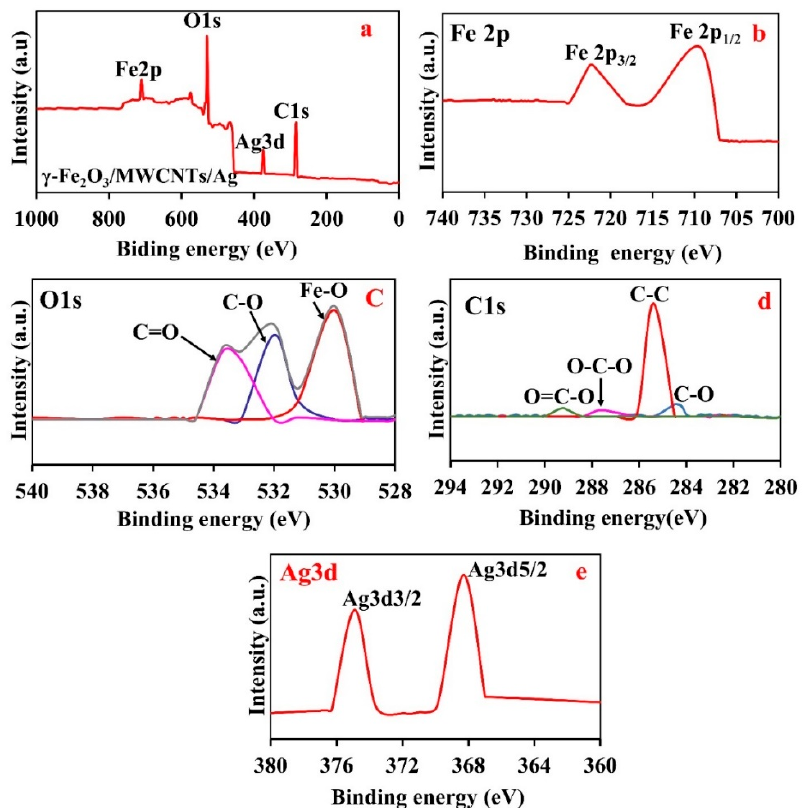
Figure 5. XPS analysis of the γ -Fe 2 O 3 /MWCNTs/Ag NC particles: ( a ) general XPS, ( b ) Fe2p, ( c ) O1s, ( d ) C1s, and ( e ) Ag3d spectrum.